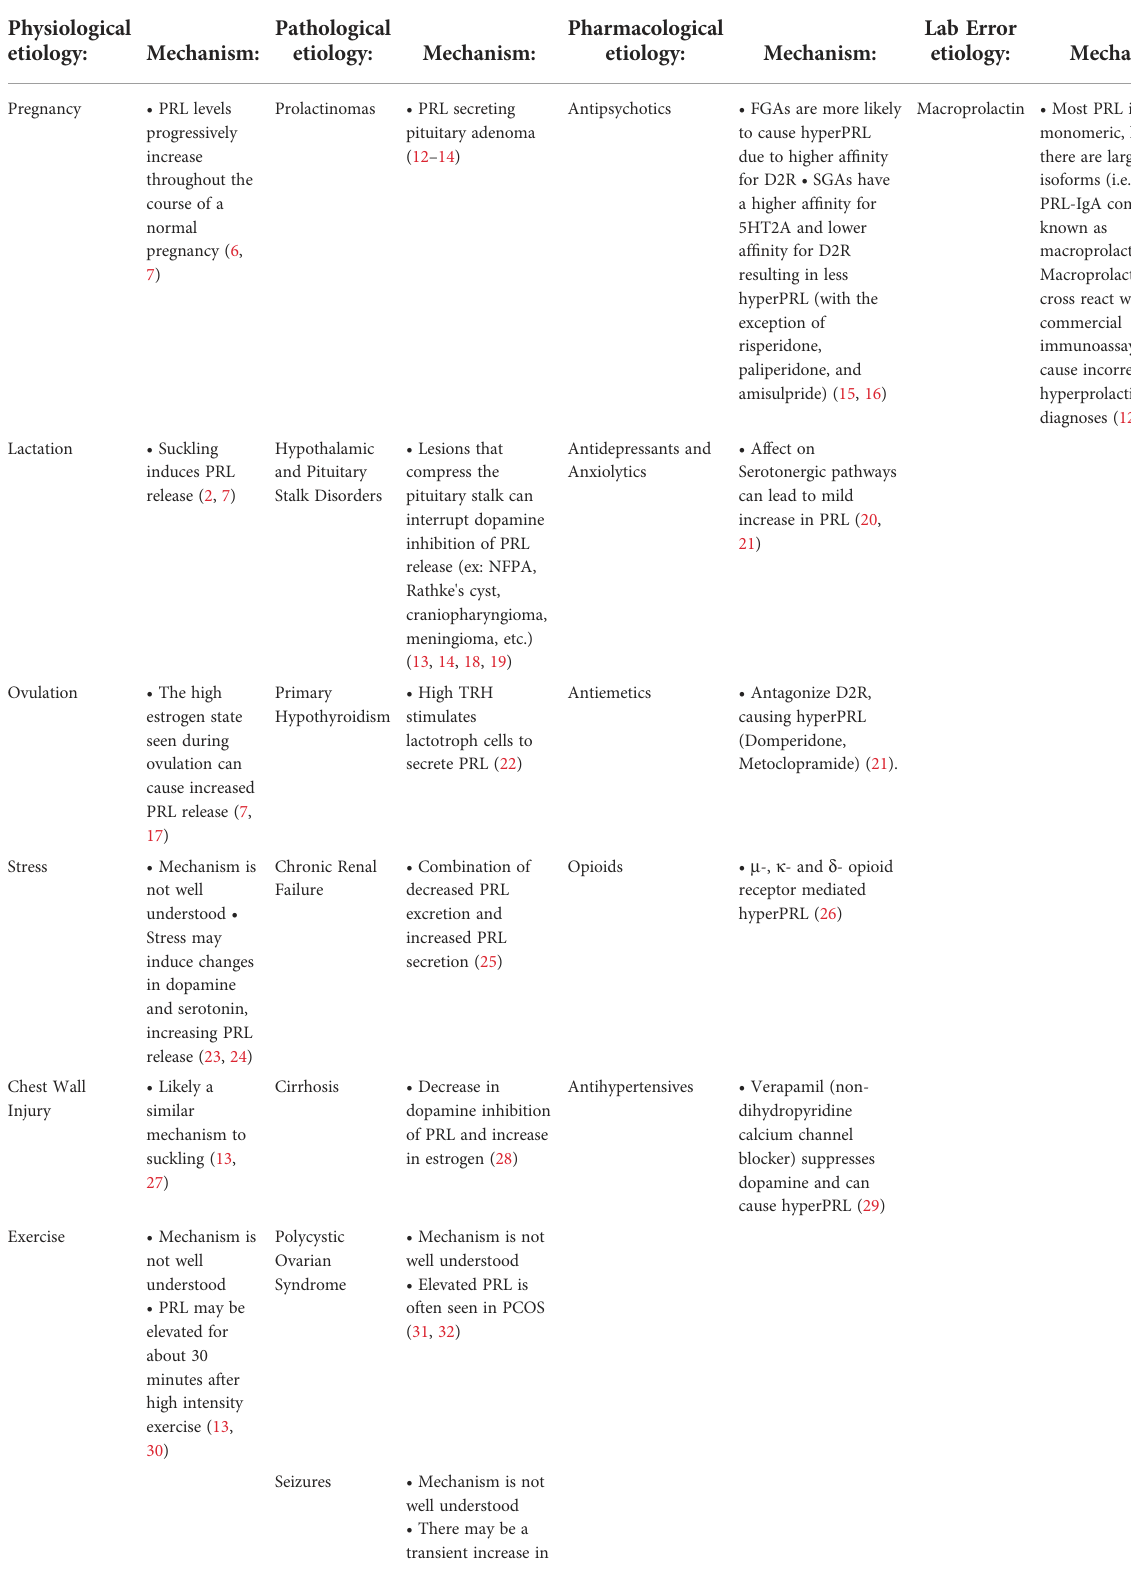
TABLE 1 Causes of Hyperprolactinemia.